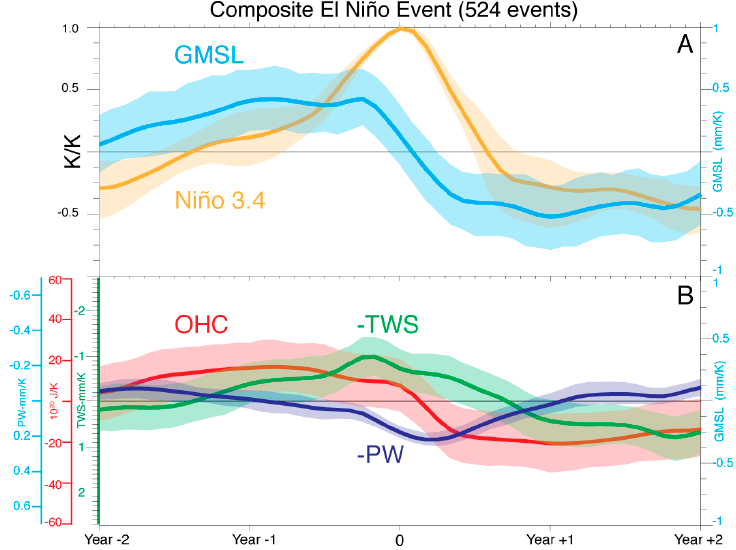
Figure 3. Summary of anomalies in: ( A ) El Niño event Niño3.4 temperature and GMSL; and ( B ) GMSL constituent terms including ocean heat content (OHC), terrestrial water storage (TWS) and precipitable water (PW). Shading indicates the σ range across ensemble members. A sign convention is used such that positive anomalies constitute an increase in GMSL.